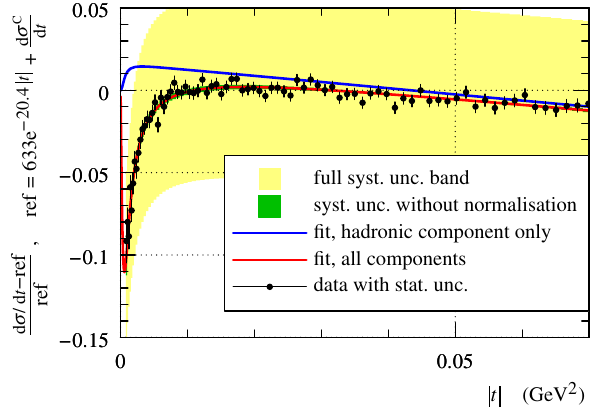
Fig. 15 Details of fit with N b = 1 and | t | max = 0 . 07GeV 2 . The fit parameters read: a = ( 643 ± 35 ) mb / GeV 2 , b 1 = ( 10 . 39 ± 0 . 03 ) GeV − 2 and ρ = 0 . 09 ± 0 .